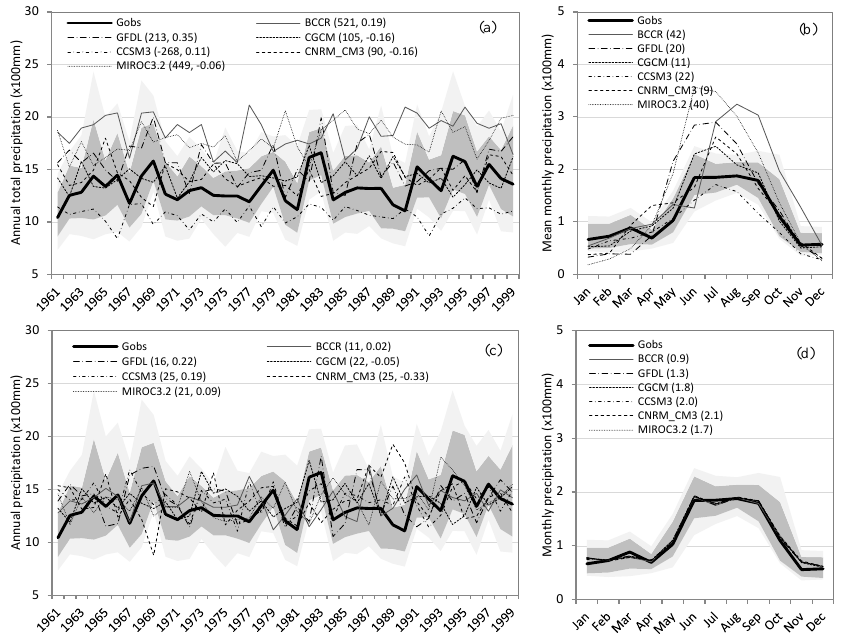
Fig. 3. Comparison of spatially averaged annual total precipitation time series (left column) and the mean monthly precipitation (right column) over Florida for gridded observation (Gobs, thick black lines), raw GCM outputs (upper row), and bias-corrected GCM results (bottom row). Units in mm. The bright and dark gray zones represent the total data range and 5th to 95th percentile of Gobs at the 12km grid scale over Florida. Mean error and correlation of GCM annual time series and mean mean error of monthly precipitation compared to Gobs are represented in the legend of each